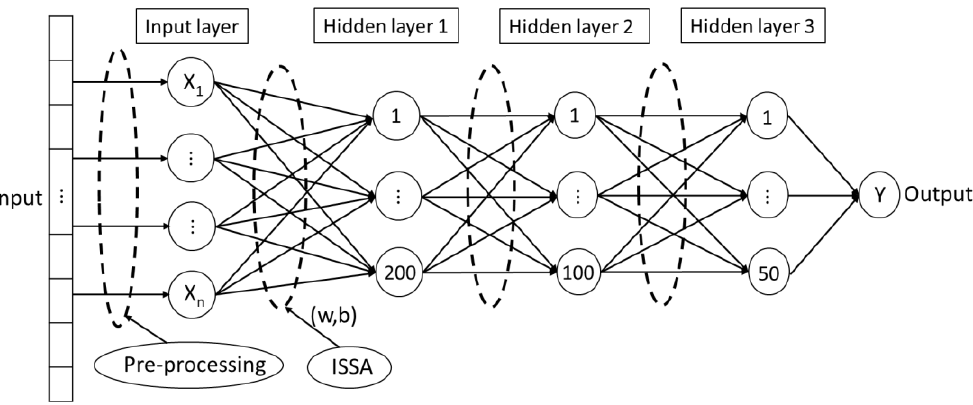
Figure 3. The structure and diagram of the prediction model based on the ISSA-DELM. The specific flow is as